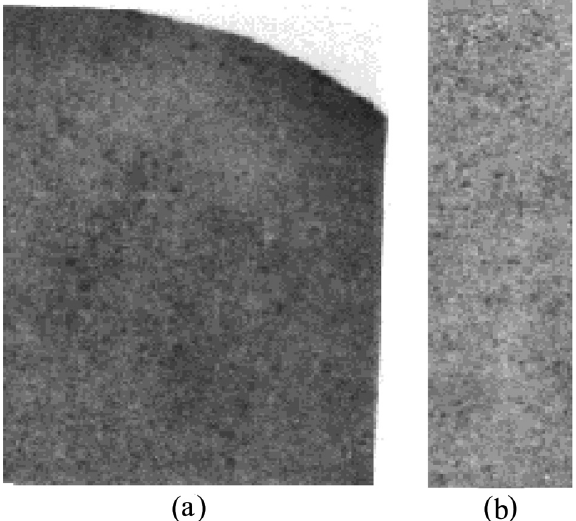
Figure 12: Macrostructure of an alloy of BT9 in cross and longitudinal sections after a broach in flat baizes at temperatures of β -areas, in the combined baizes of ( α þ β )-areas and on RFM in β